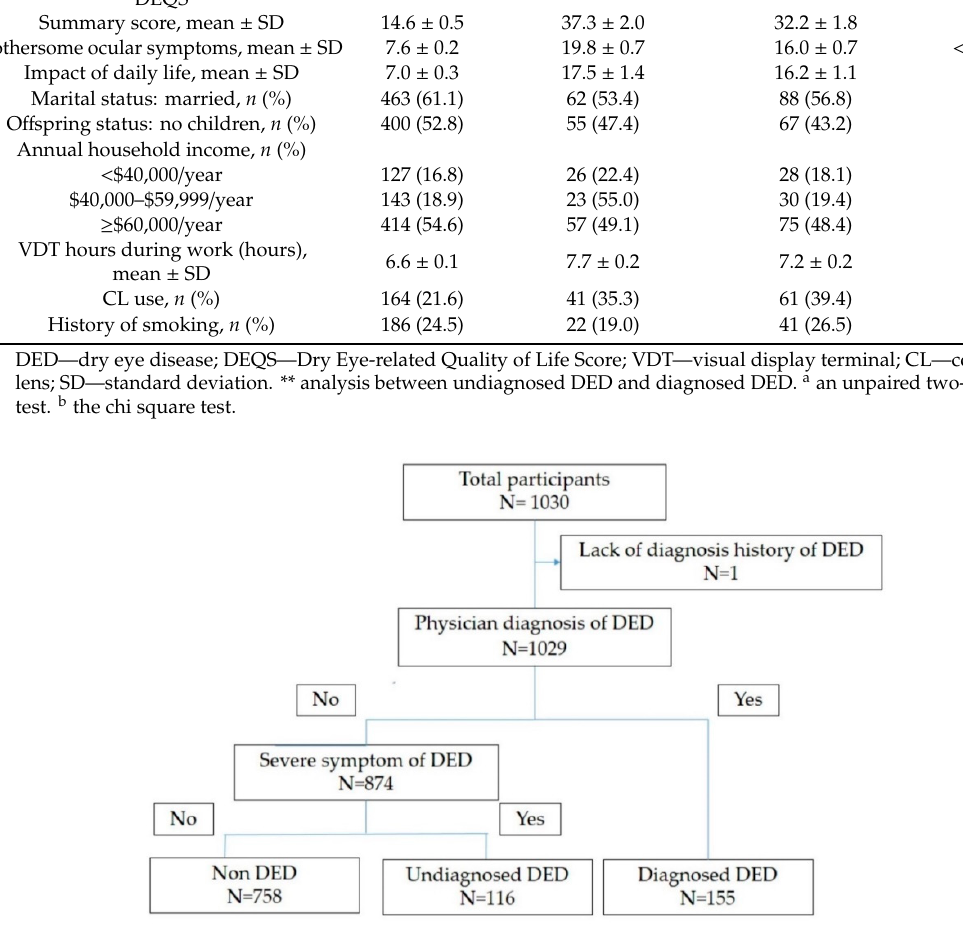
Figure 1. Participants flow chart. The participants were stratified with diagnosed history and symptom of dry eye disease (DED). Diagnosed DED—physician diagnosis of DED ( + ); undiagnosed DED—physician diagnosis of DED ( − ) and severe symptoms of DED ( + ); non DED—physician diagnosis of DED ( − ) and severe symptoms of DED ( − ).